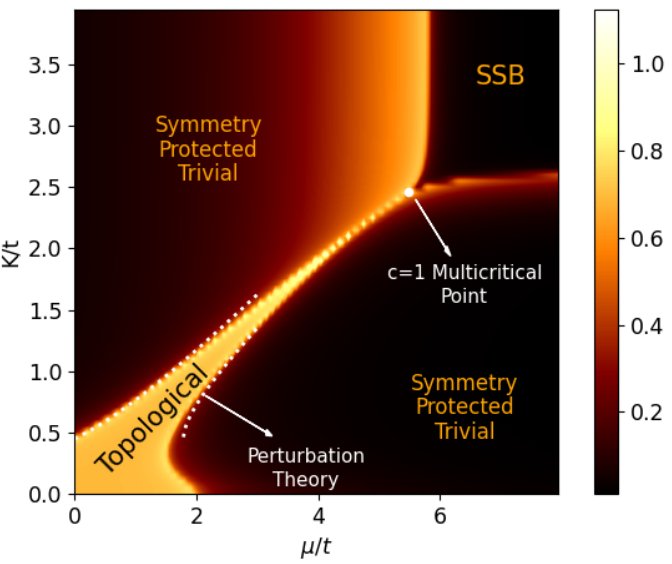
Figure 6: Numerical results for the half-chain entanglement entropy at h / t = 5. The white dotted lines are the analytical results from perturbation theory at large h , see Eq. (47). This approximation is valid for t 2 / h (cid:28) K (cid:28) h and µ (cid:28) h , where it reproduces correctly the phase boundaries. However, it cannot be used to infer that the critical lines converge into a c = 1 multicritical